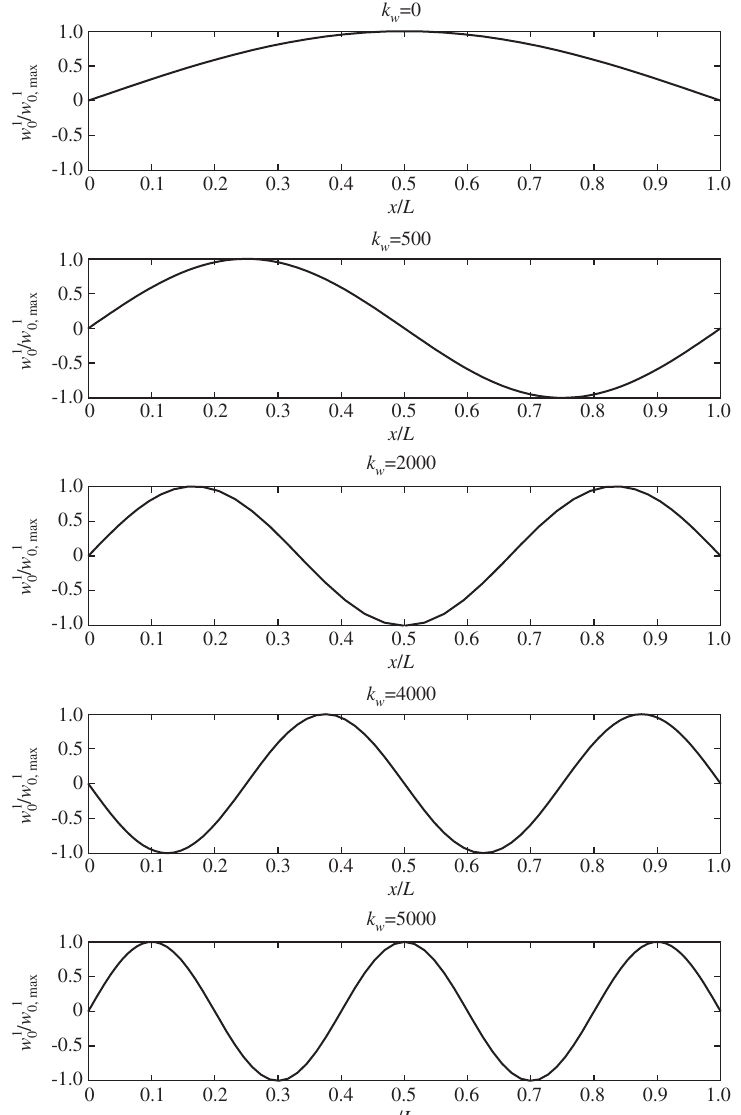
Figure 6 Buckled configurations of S-S composite laminated beams with L / h = 20 and [0/90/0] lay-up resting of Winkler foundation.